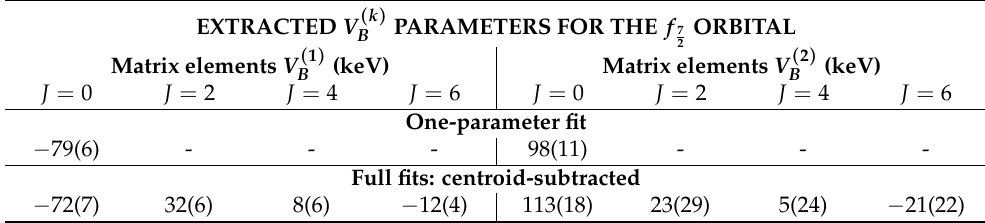
Table 1. Data collected from Refs. [17,18]. The isovector V elements, for f 7/2 pairs, extracted from fits across the whole f 7/2 shell (see text for details). For the full fits, a monopole centroid has been subtracted as part of the fitting process to allow the J -dependence to be fully evaluated. The numbers in the parentheses are the errors on the fitted